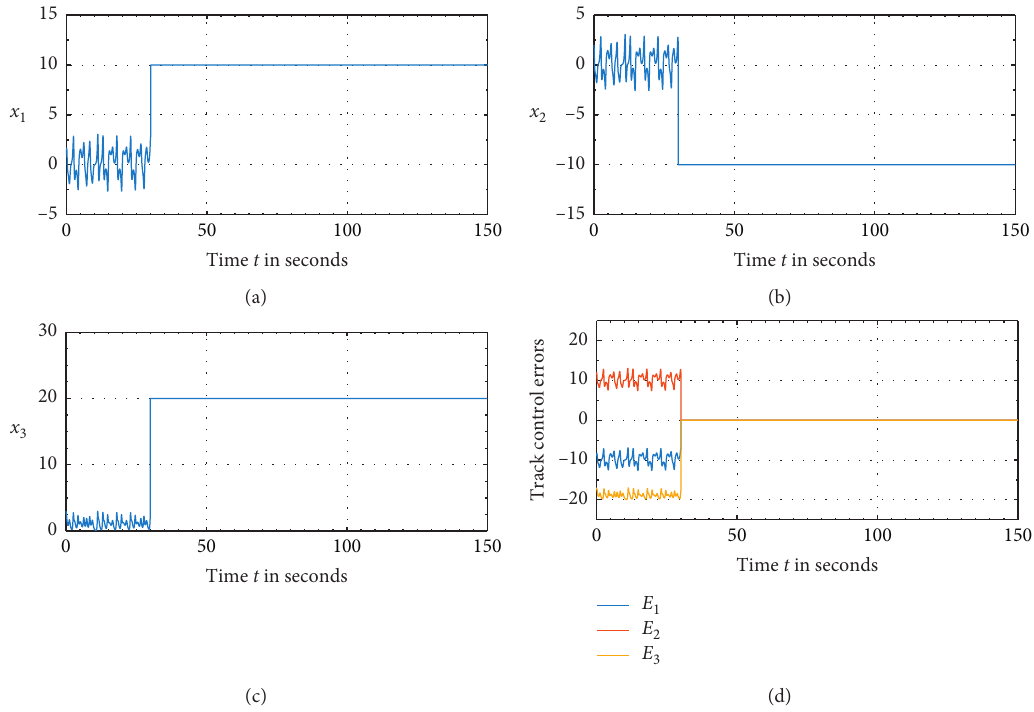
Figure 10: State dynamics under the track control method with reference ( 10 , − 10 , 20 ) and the controller gain k � − 50, where the controller is applied after 30secs. (a) The state variable x and E 3